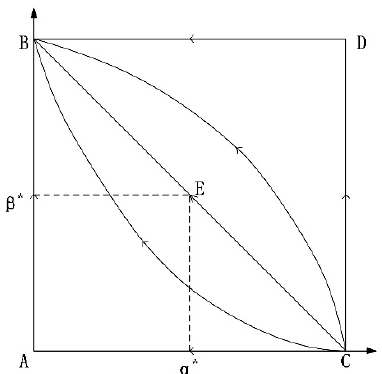
Figure 3. Scenario 3 evolutionary path between local government and coal-related enterprises.